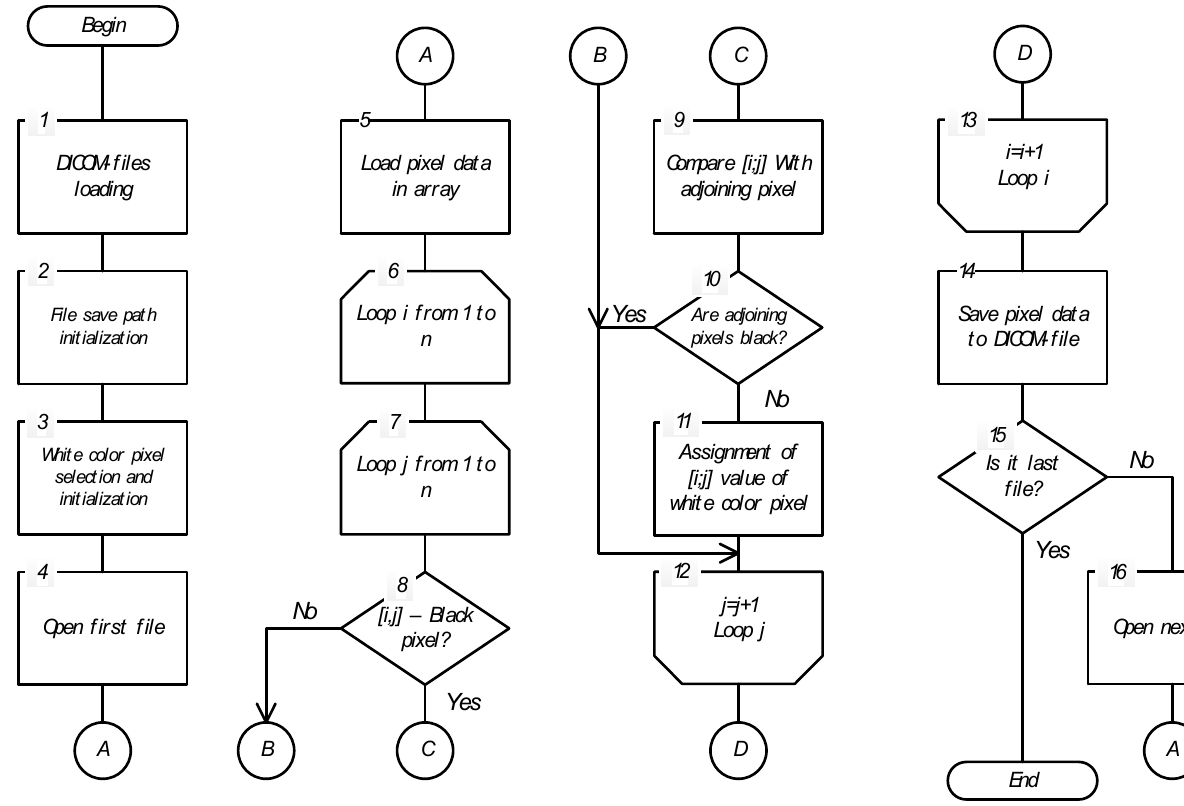
Figure 3. DICOM images processing